Question: Identify the chart type used in this figure.
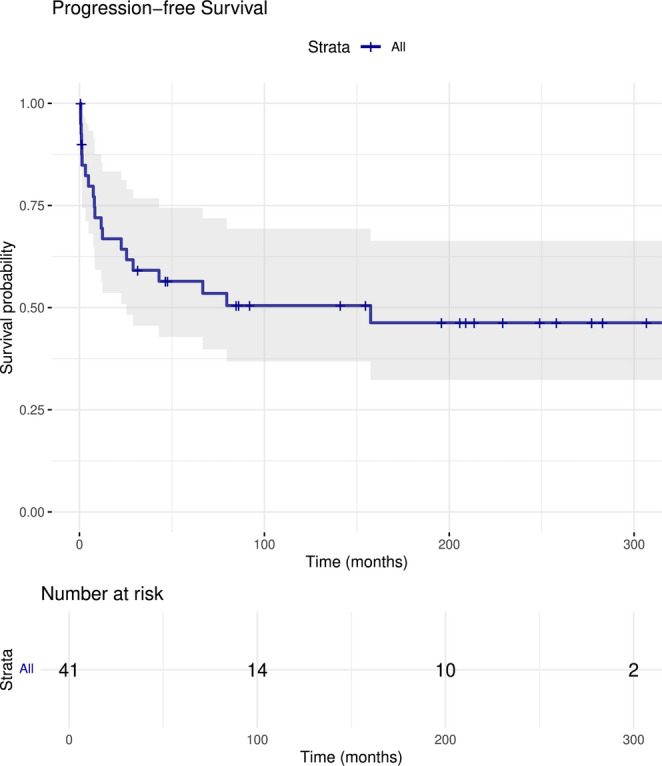
Answer: survival